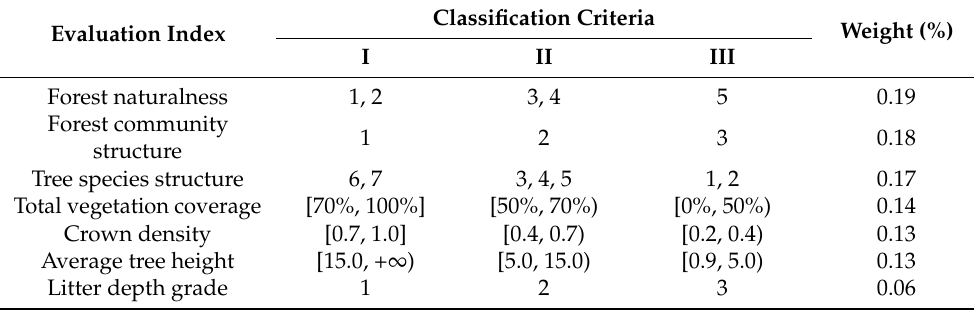
Table 3. Plot evaluation indicators and weights.